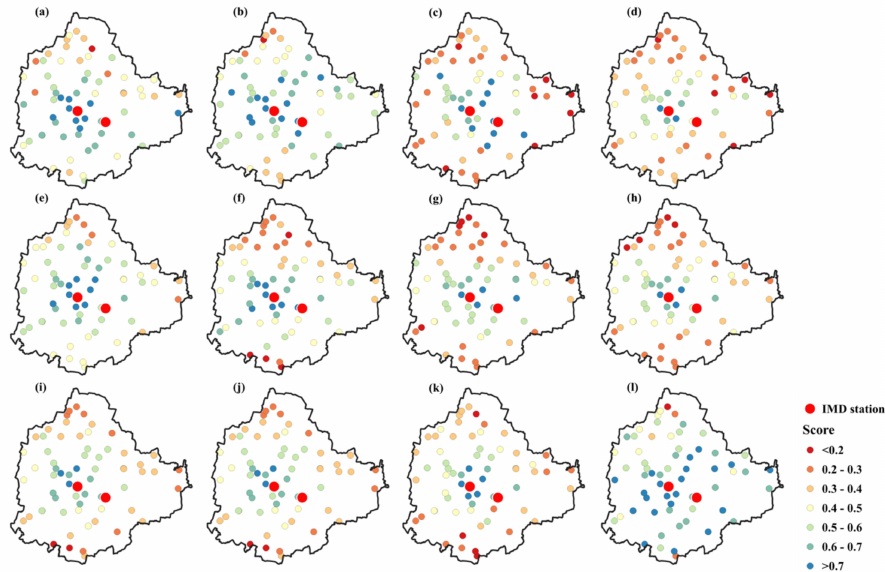
Figure 3. Performance of the random forest model shown for 12 months (( a – l ) January–December). The coefficient of determination values for the KSNDMC stations are marked in various colors. Additionally, the locations of the two IMD stations are marked in red.